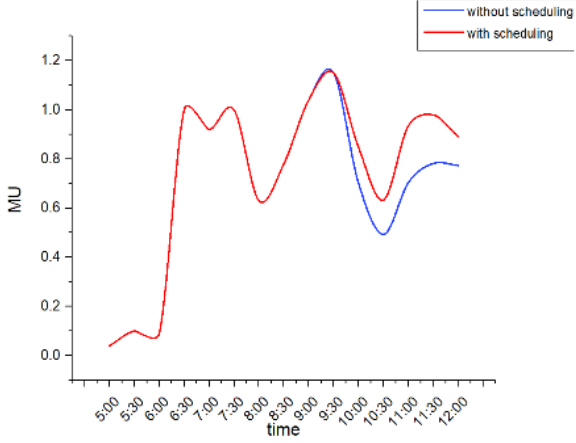
Figure 10. Mean utilization of bikes with and without scheduling strategies.